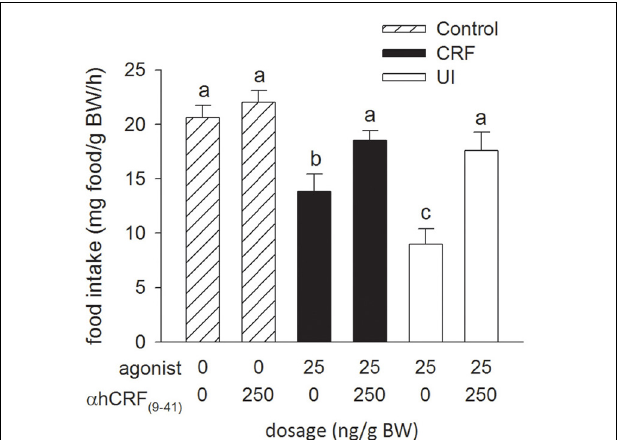
FIGURE 2 | Effects of i.c.v. injections of teleost Ringer’s (0.2% NaHCO 3 in 0.6% NaCl; Control treatment), rainbow trout CRF (rtCRF) or